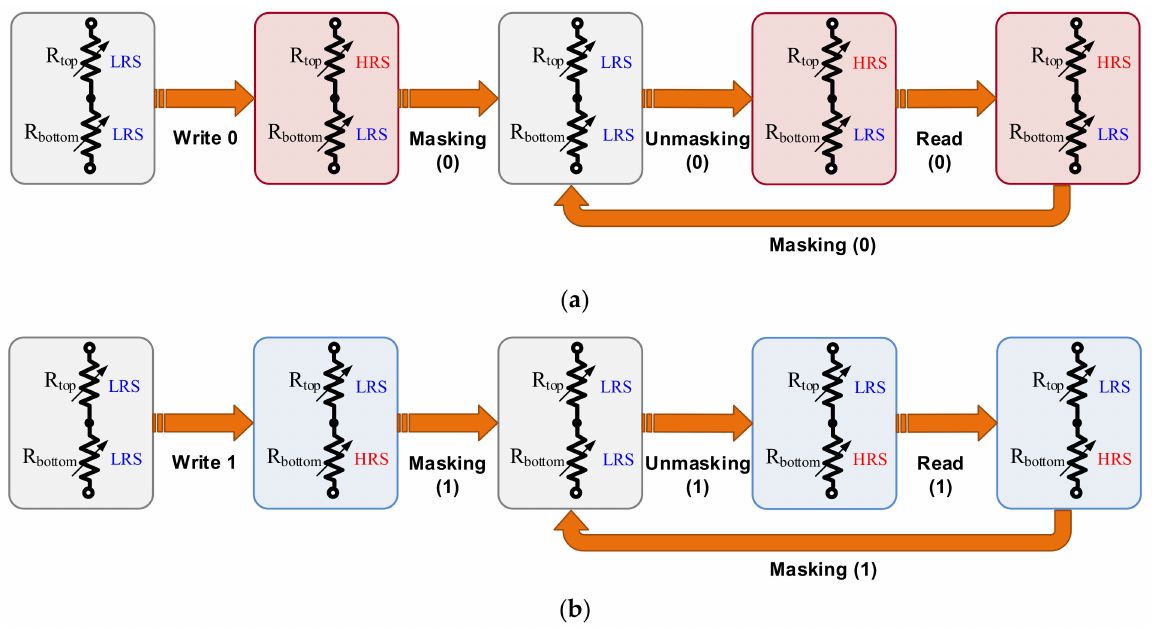
Figure 7. The sequence of operations and resistance state of the devices for the secure memory cell: ( a ) Initially writing ‘0’; ( b ) Initially writing ‘1’.